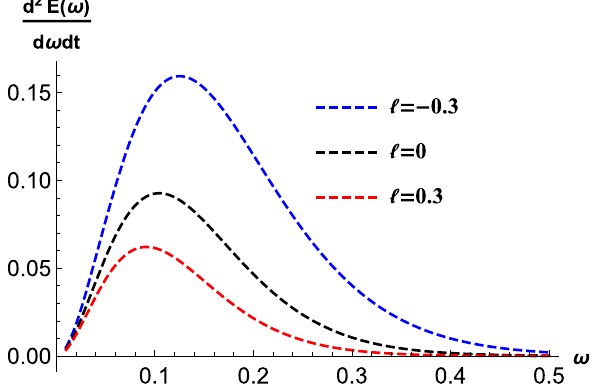
Fig. 19 It gives variation of emission rate against ω for various values of (cid:2) with b = 0 . 02 M 2 and ˆ a = 0 . 1